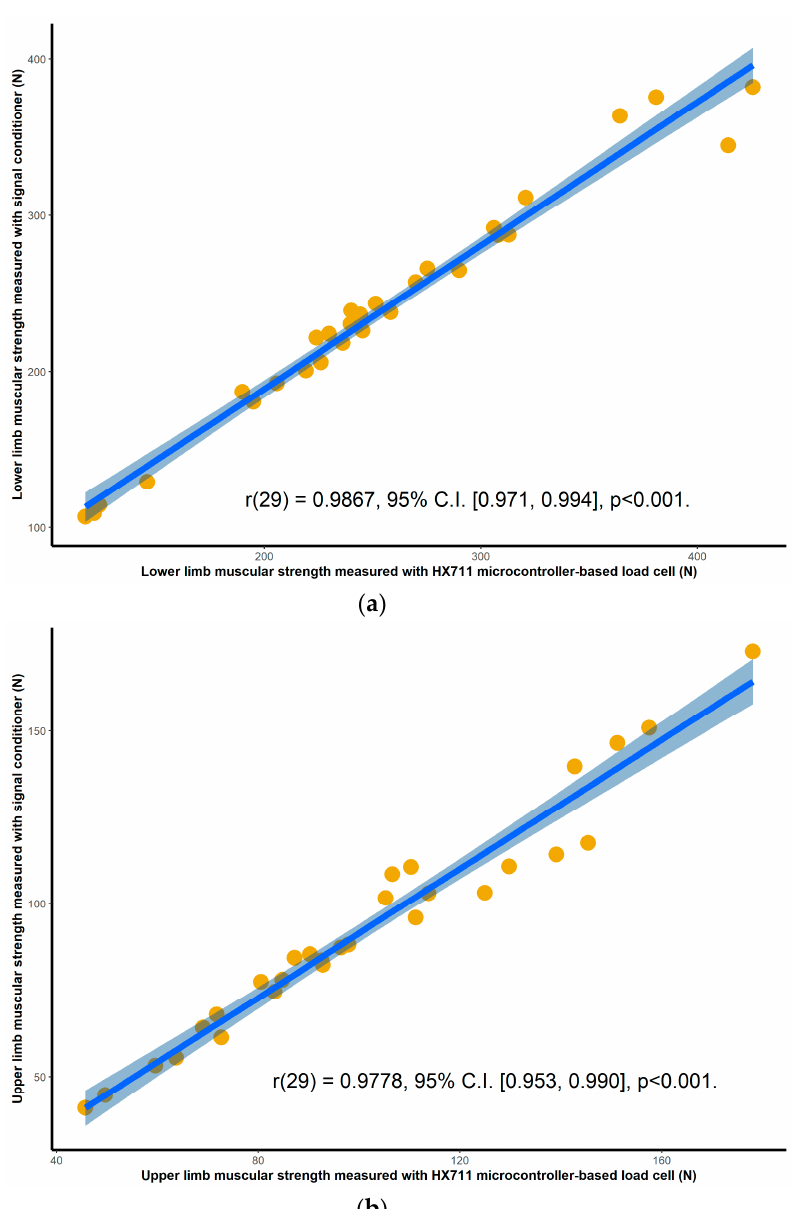
Figure 4. Session one correlations between the commercial signal conditioner and the HX711 microcontroller-based load cell for: ( a ) maximal isometric leg extension; ( b ) maximal isometric bicep flexion. The blue line and the shaded area are the linear regression slope and its 95% confidence region.